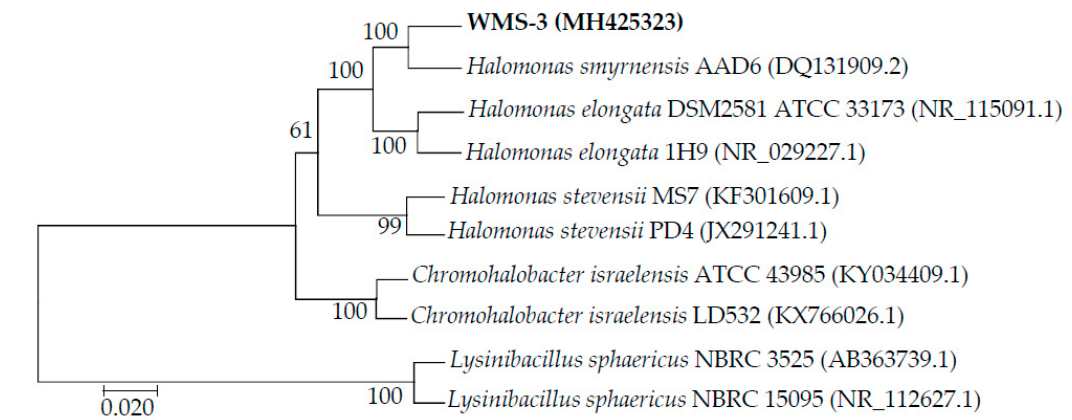
Figure 1. Phylogenetic tree of the H. smyrnensis WMS-3 bacteria constructed with neighbor-joining method based on 16S rDNA sequence alignment.